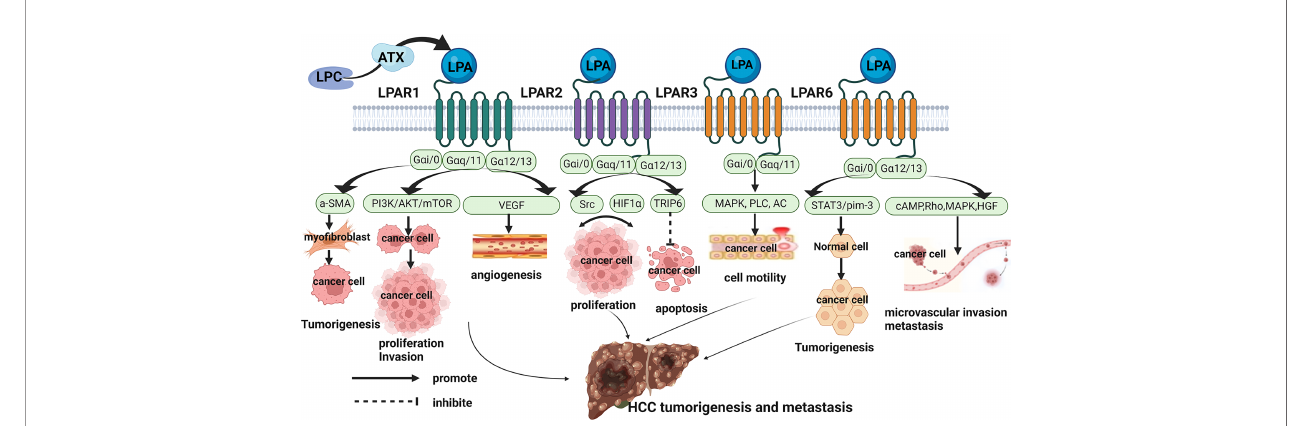
FIGURE 2 | Role and Mechanisms of ATX/LPA in hepatocellular carcinoma. LPAR1 promoted the occurrence, proliferation, migration and angiogenesis of HCC by coupling with G a i/0, G a q/11, and G a 12/13, and activating downstream a-SMA, PI3K/AKT/mTOR, VEGF pathways. LPAR2 may regulate the proliferation of HCC cells through Src signaling pathway and HIF1 a pathway. On the other hand, LPAR2 may interact with TRIP to inhibit apoptosis of HCC cells. LPAR3 promoted tumor cell motility in HCC through coupling to G a i/0 and G a 11/q to mediate downstream activation of MAPK, PLC, and inactivation of AC. LPAR6 supported the tumorigenicity of HCC through a STAT3/pim-3-dependent mechanism. And LPAR6 increased microvascular invasion in HCC through mediating cAMP reduction, Rho-dependent morphological changes, MAPK and HGF